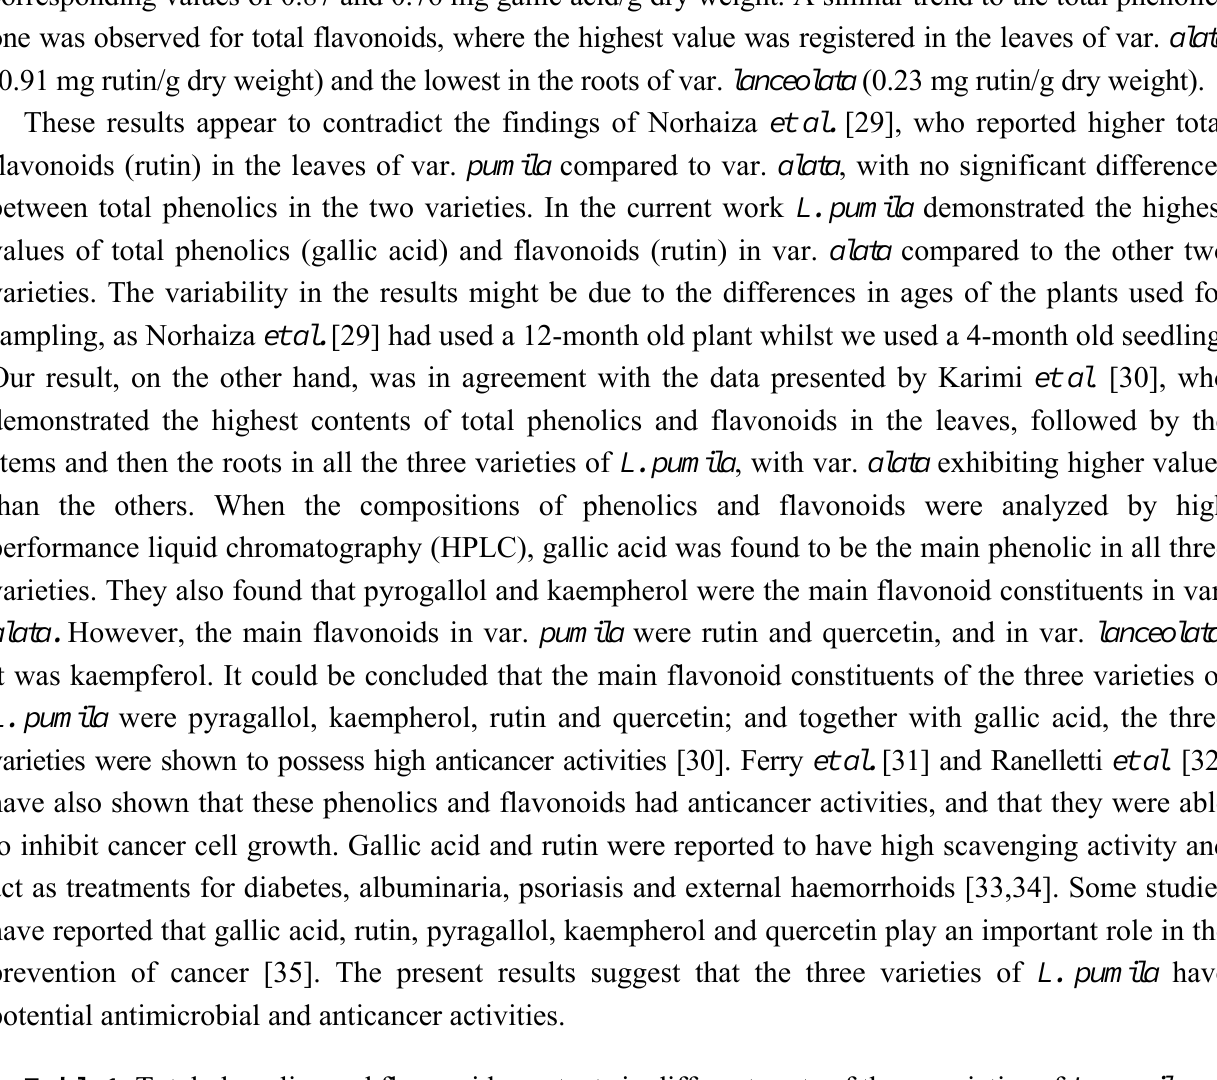
Table 1. Total phenolics and flavonoids contents in different parts of three varieties of L. pumila